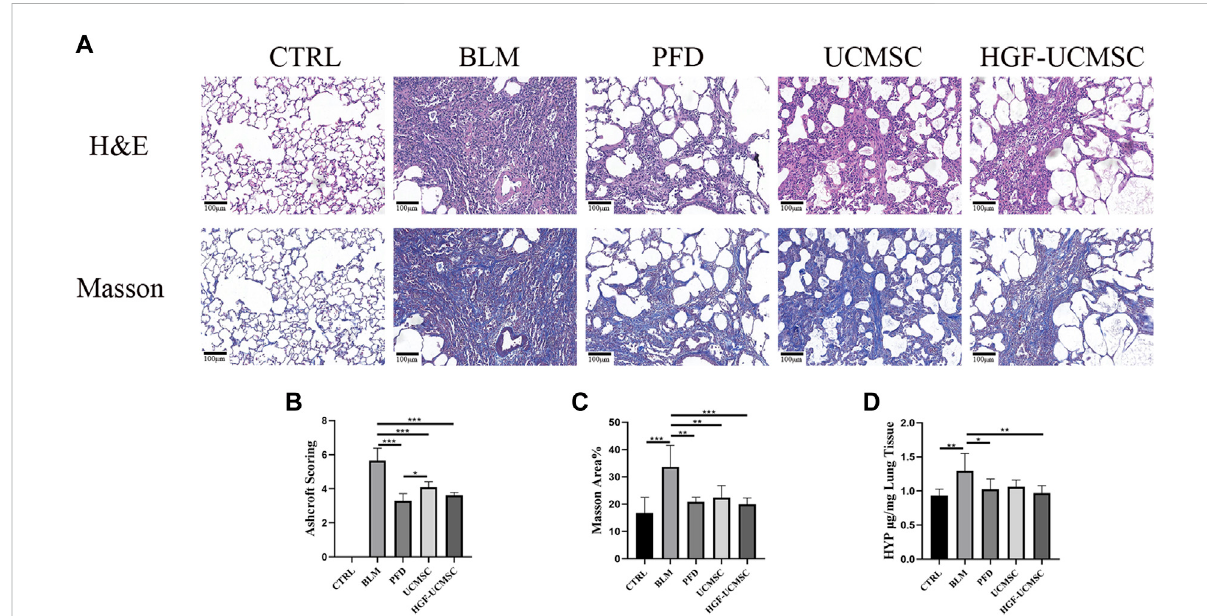
FIGURE 4 Evaluation of pulmonary histopathology. (A) Lung sections were stained with H&E or Masson ’ s trichrome (magni fi cation: ×100). (B) Ashcroft scoring was performed in H&E-stained sections (C) The percentage positive area was calculated in Masson ’ s trichrome-stained sections (D) HYP concentrations were detected in the lungs. Values are presented in mean ± standard deviation. * p < 0.05; ** p < 0.01; *** p <